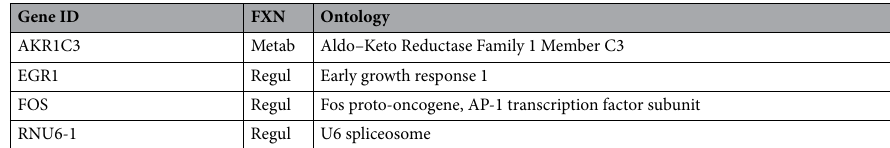
Table 3. Identification of altered gene expression in gingival tissues: comparing healthy versus diseased gingival tissues (n = 43; in all cases levels of gene expression were elevated in healthy tissues); during initiation/ early progression of disease (n = 45); during late progression of disease (n = 46); and comparing baseline healthy tissues to clinically resolved lesions (n = 33). The Adap genes are the human ID designation related to antibody nucleotide sequences of the macaque probes. Numerous of the matching macaque sequence Ig gene IDs are delineated in Thulliere et al. 75 . Fxn denotes functional categorization of genes: Adap adaptive immune response, Conn connective tissue/bone, Epi epithelium, Imm immune response, Inflam inflammation, Metab metabolic, Regul regulatory, Auto autophagy/apoptosis, Sig cellular signaling, UA unassigned to any of these functions.